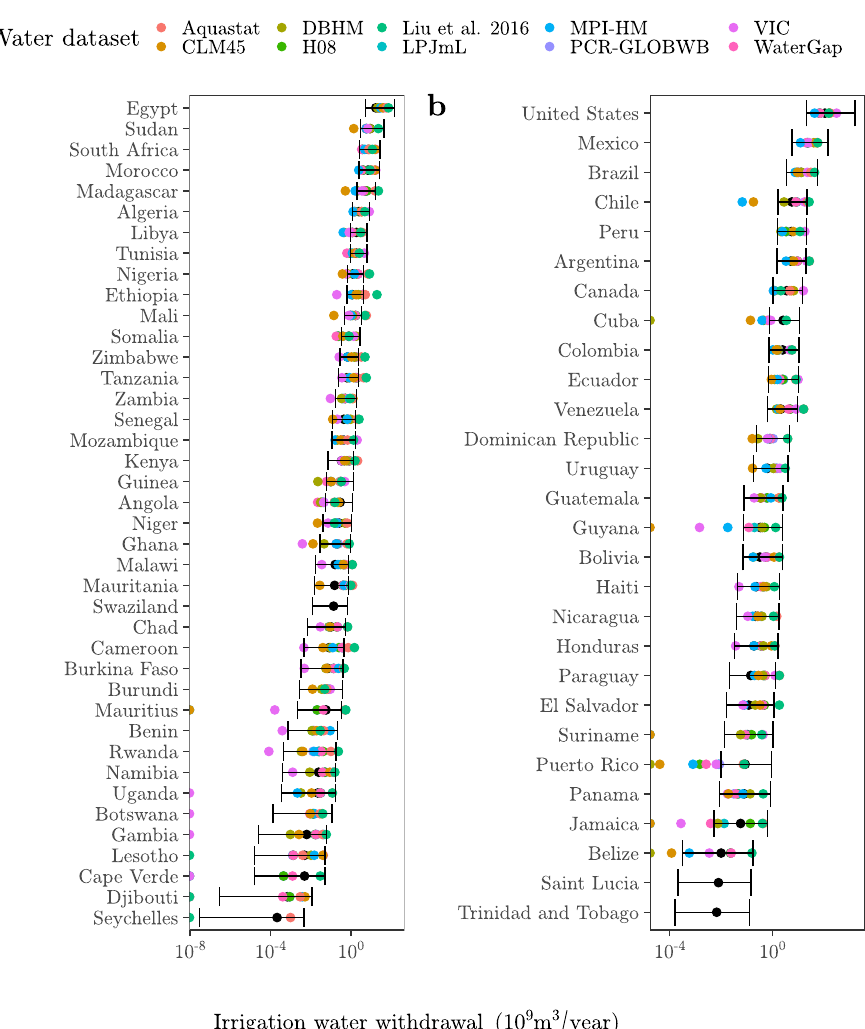
Fig. 3 Comparison between our predictions and the GMs estimations. The black dots and the error bars show the median, the minimum and the maximum irrigation water withdrawal values predicted from the irrigated areas reported by the FAO-GMIA 96 (Methods). The coloured dots show the irrigation water withdrawal estimates outputted by the GMs (DBHM, H08, LPJmL, MPI-HM, PCR-GLOBWB, VIC, CLM45, WaterGap) or reported by the FAO-based datasets (Aquastat, Liu et al. 19 ). a Africa. b